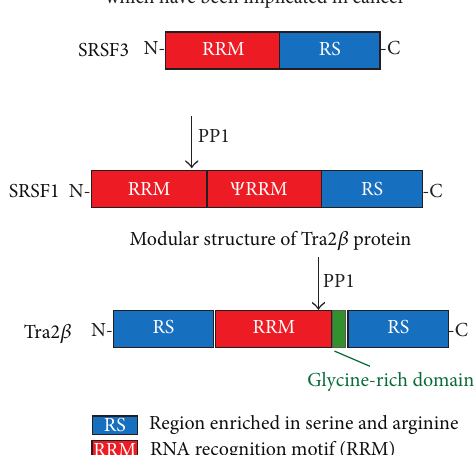
Figure 1: Modular structure of the core SR family proteins SRSF1 (also known as ASF/SF2) and SRSF3 (also known as SRp20) and the SR-like protein Tra2 𝛽 . The RNA recognition motif (RRM) binds to target RNAs, and the RS region is responsible for protein-protein interactions. SRSF1 has a second RRM, annotated 𝜓 RRM. SRSF1 and Tra2 𝛽 have a PP1 docking